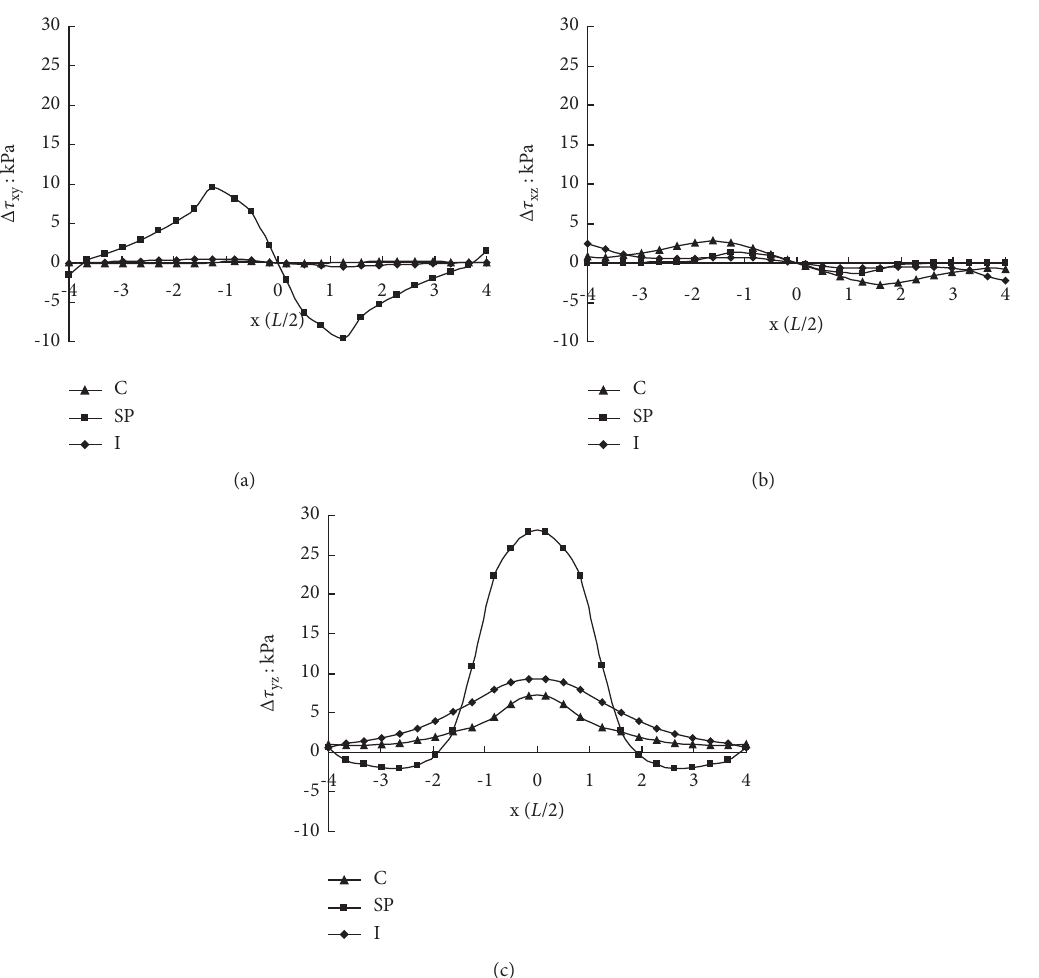
Figure 9: (a) Δ τ xy , (b) Δ τ xz , and (c) Δ τ yz for various soil elements along tunnel axis after excavation for case S. Monitored elements: C, crown; SP, right spring line; and I,